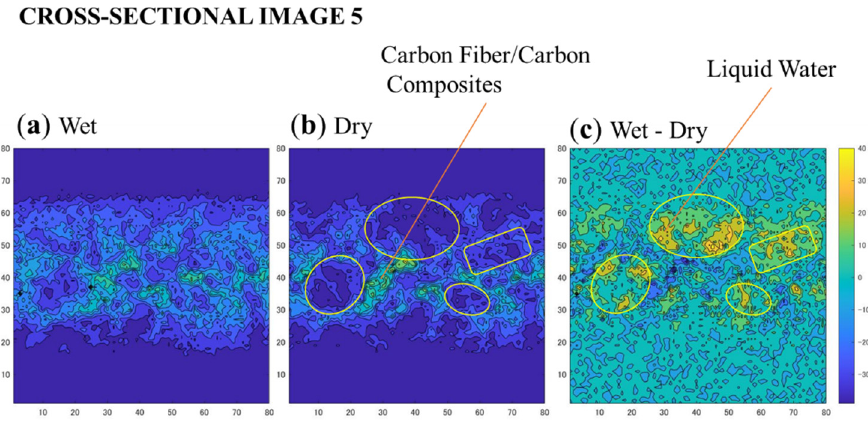
Figure 6. Imaging liquid water in cross-section 5: ( a ) wet GDL material sample; ( b ) dry GDL material sample; ( c ) difference image between the wet and dry samples. In ( c ), liquid water is observed in the pore spaces in the GDL material sample, which is indicated by the yellow lines. Negative contributions are observed on the region of the carbon fibers, indicating interactions between the GDL materials and liquid water.